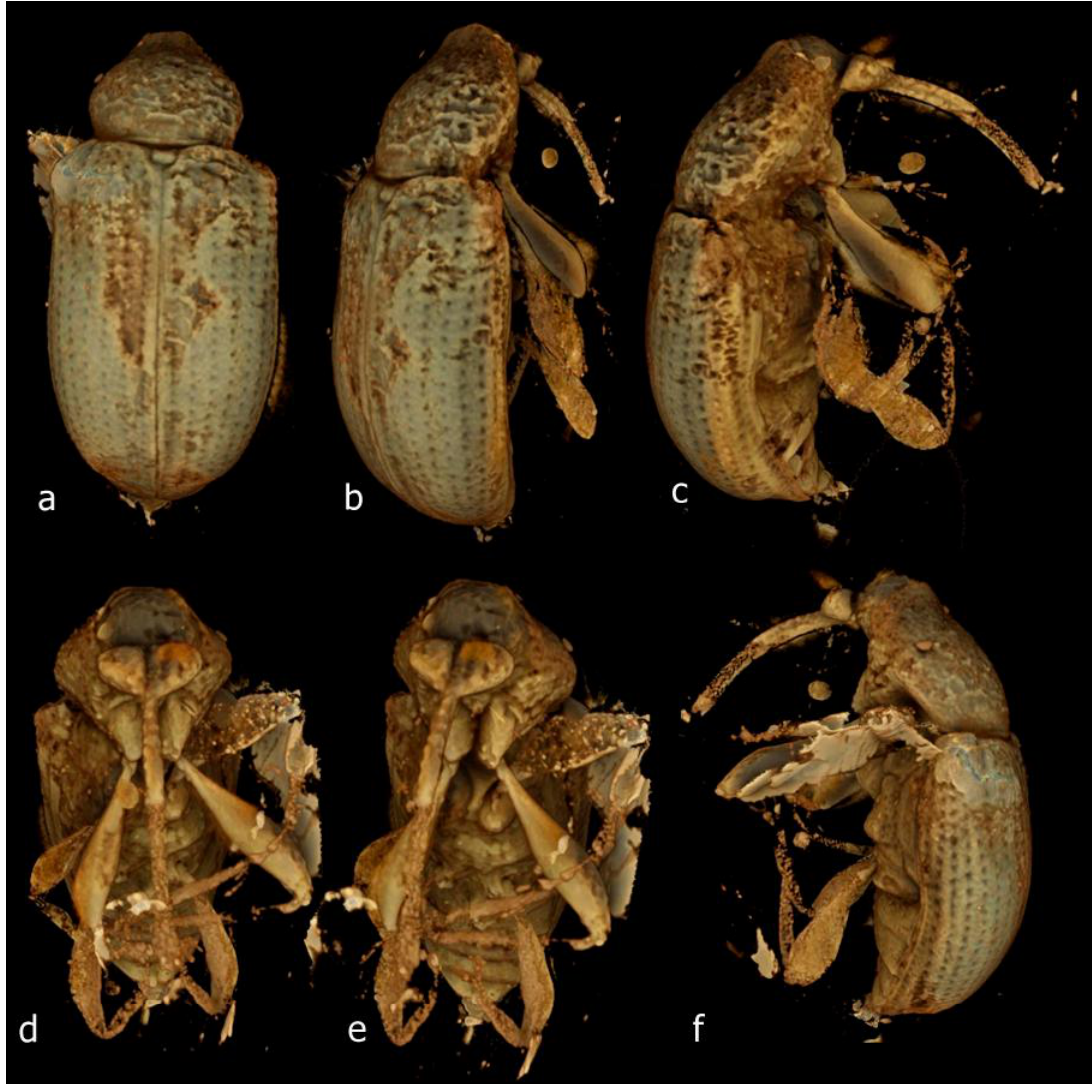
Figure 69. Myanmarus caviventris sp. n., holotype. Habitus images extracted from a micro-CT scanning reconstruction (see also Video S6). Dorsal, revealing punctate stria not clearly visible under light microscopy ( a ); dorsal oblique ( b ); right lateral ( c ); ventral ( d ); ventral ( e ); left lateral ( f ).